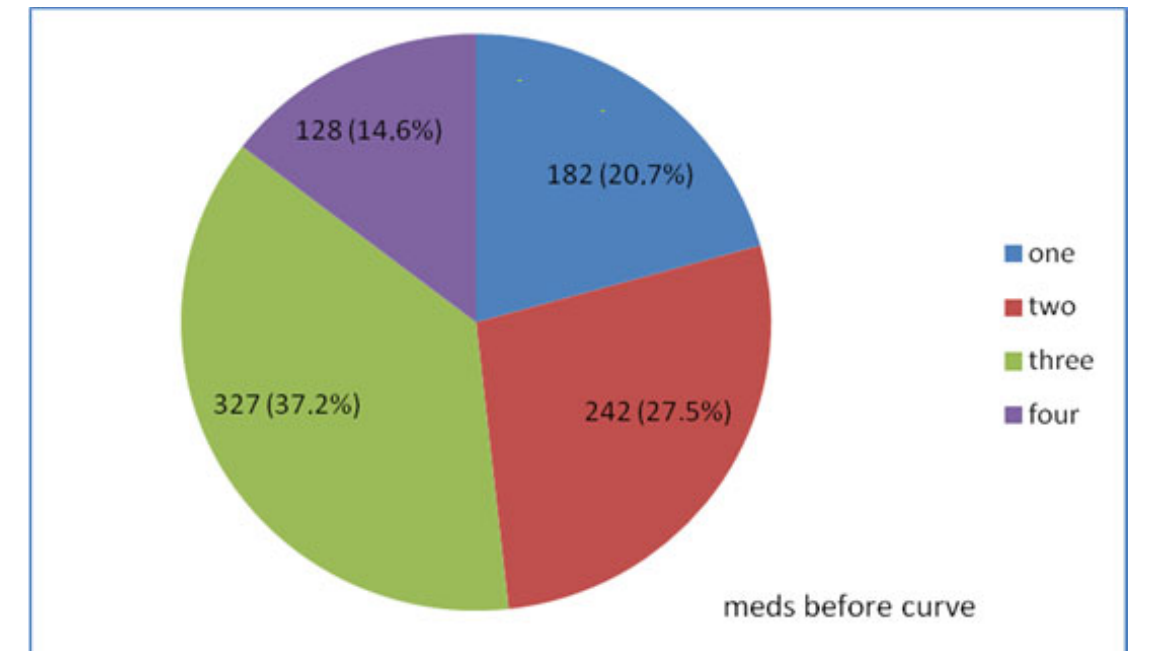
Figure 2. Treatment based on the number of medications taken before IOP monitoring of 879 patients.